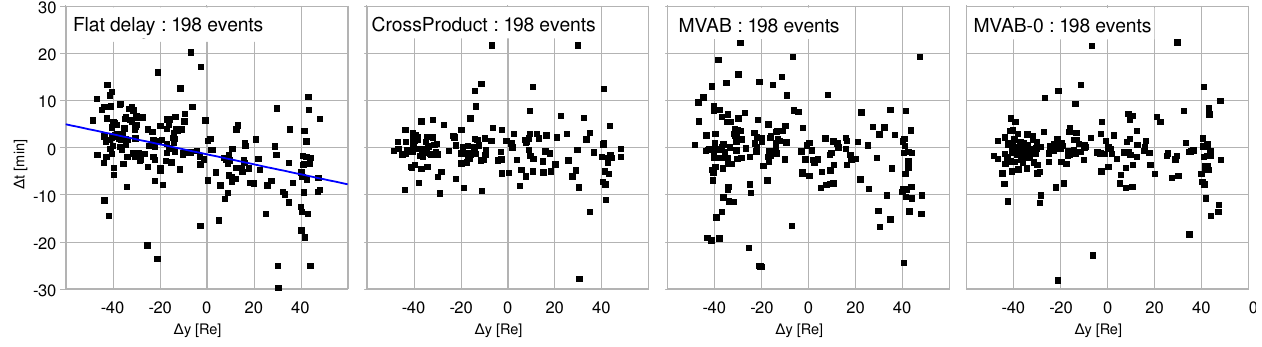
Fig. 4. Arrival time errors as function of the separation between ACE and Cluster in the Y GSE direction. The vertical axis, common to all panels, shows the time differences 1t = t model − t observed , and the horizontal axes show the Y GSE separation between the ACE and Cluster spacecraft, 1Y = Y ACE − Y CLUSTER for each method. Since the Cluster orbit in our data set has only has a maximum Y GSE position of ± 8 R E , this plot can roughly be interpreted as the dependence of the ACE Y GSE position. The blue line in the panel for flat delay indicates the linear trend calculated from the data points.